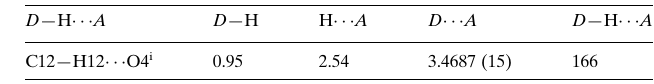
Hydrogen-bond geometry (A˚ , (cid:2)